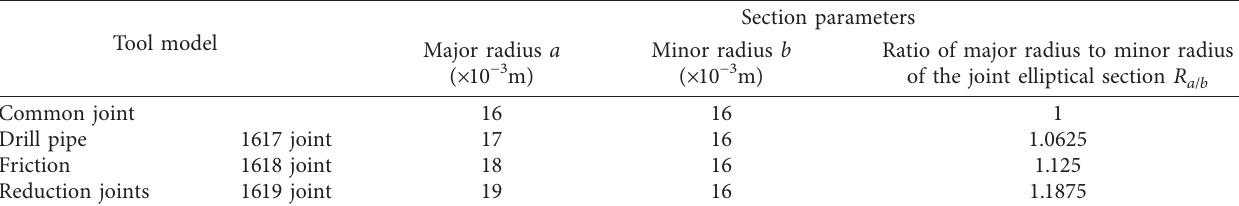
Table 1: Section parameters of different joints models.